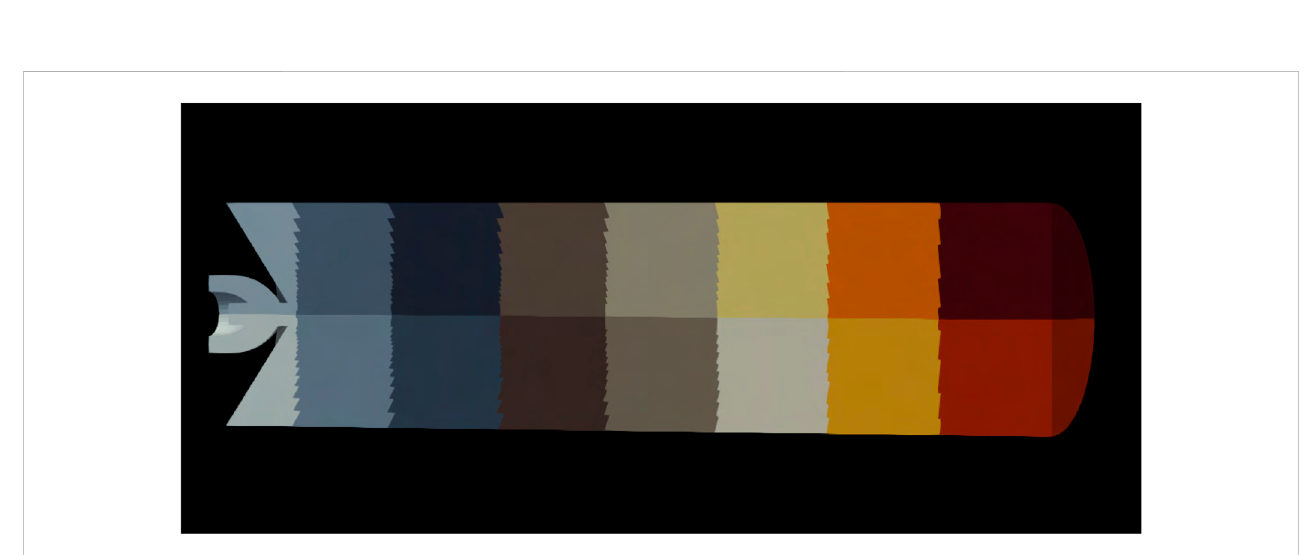
FIGURE 9 Computational geometry section distributed across different processors according to the Simple domain decomposition